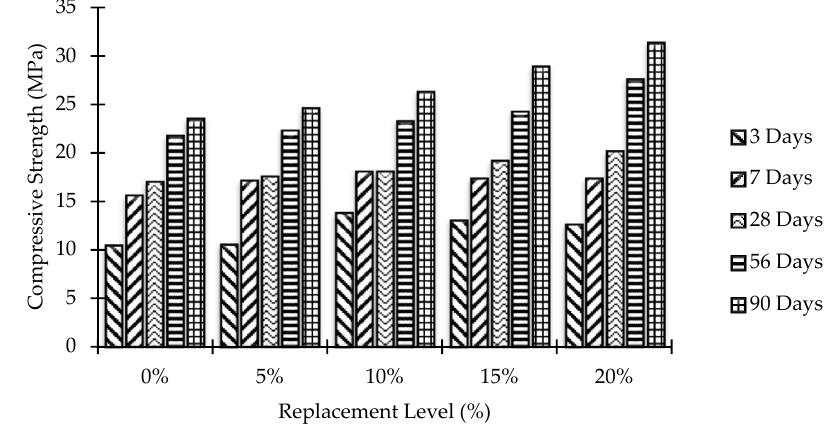
Figure 6. Compressive strength of MK blended mixes with aging.